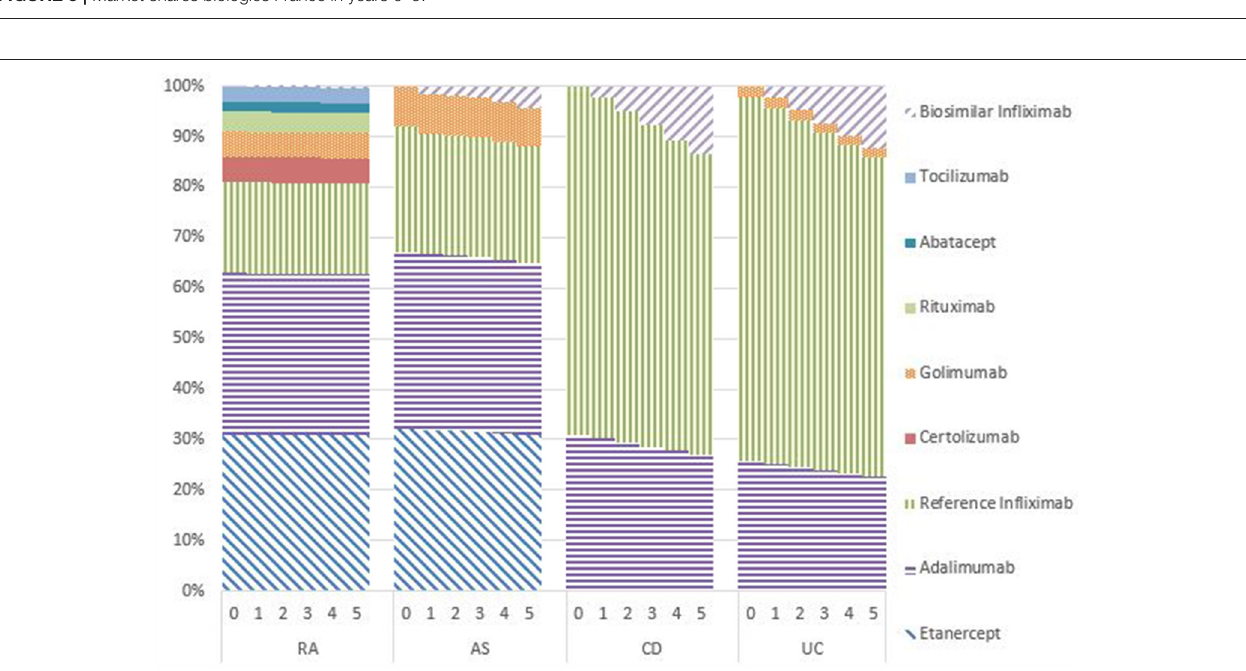
FIGURE 4 | Market shares biologics Spain in years